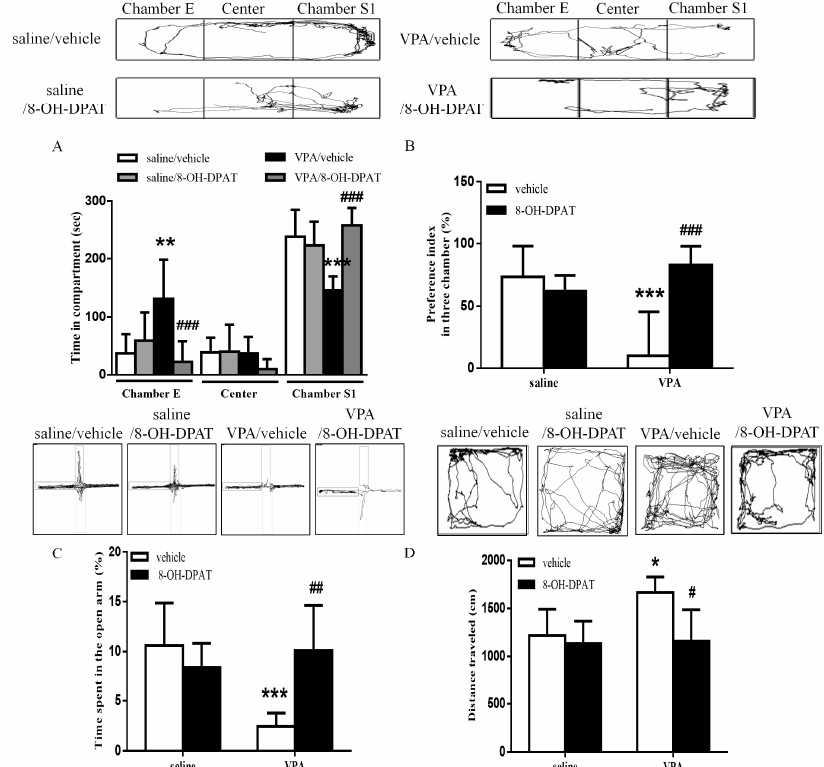
Figure 3. 8-OH-DPAT treatment increased social interaction and ameliorated anxiety and hyperlocomotion in the VPA-exposed offspring. ( A ) Time spent by the VPA-exposed offspring in chamber E, the center chamber, and chamber S1 during the three-chamber social interaction test following local infusion of 8-OH-DPAT (10 µ g/ µ L) into the ILPFC; ( B ) preference index in the social interaction test; ( C ) the percentage in the open arms after 8-OH-DPAT treatments; ( D ) bar